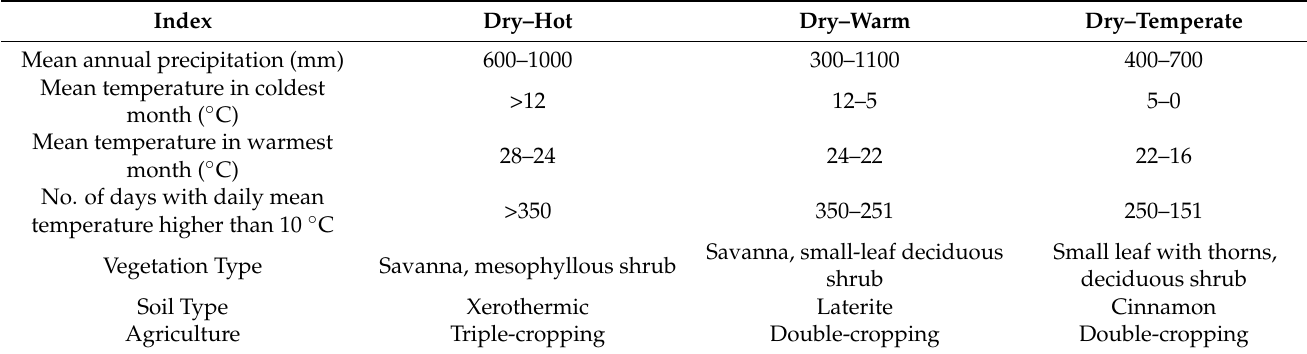
Table 1. Classification criteria of dry valleys